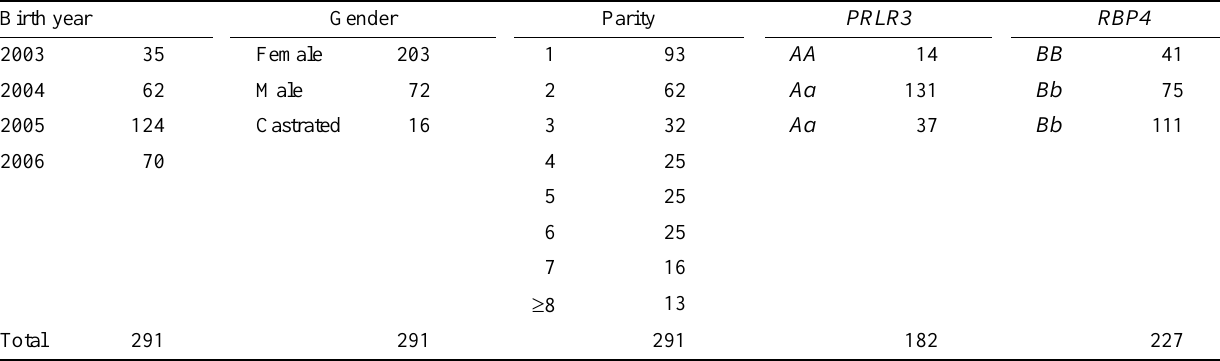
Table 2. Distribution of production traits by genotype, birth year and gender Birth year